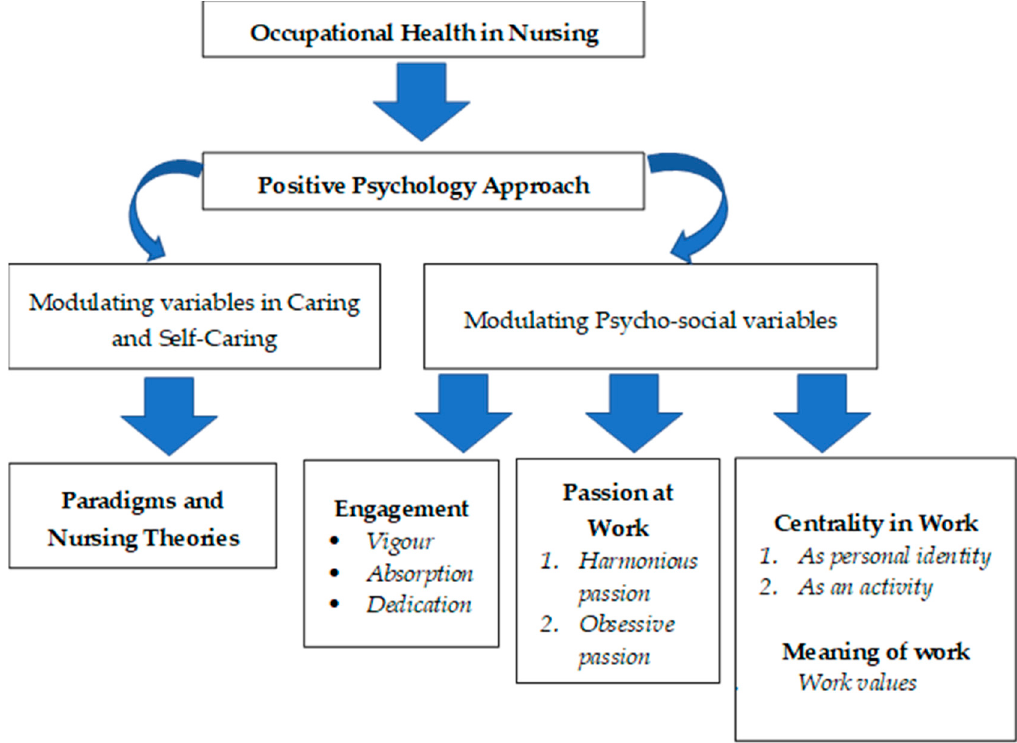
Figure 1. Concepts flowchart.